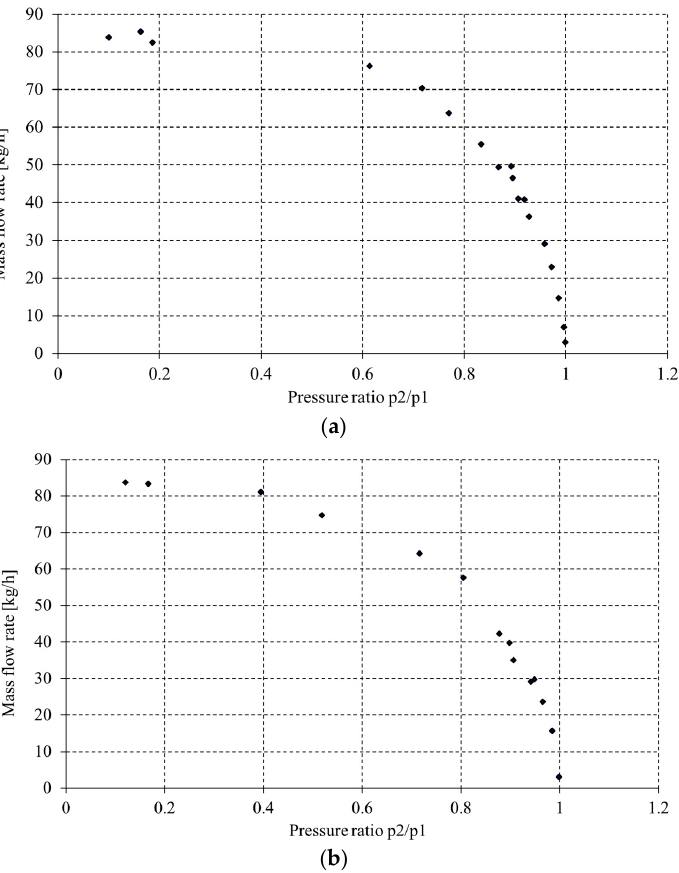
Figure 7. Dependence of mass flow rate on pressure ratio for 5/2 PARKER No. 341NO3 manifold, working position: ( a ) currentless, ( b ) coil energized.